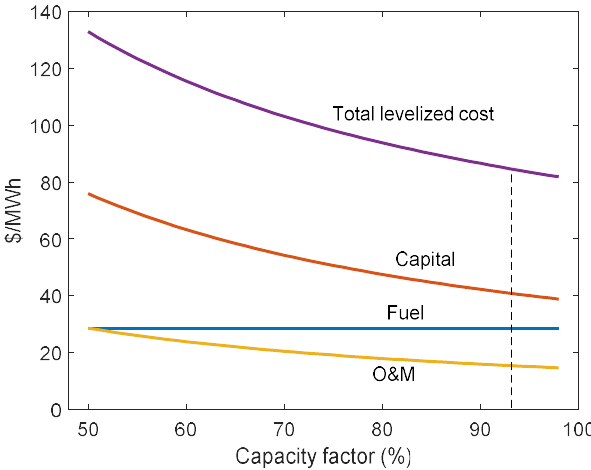
Figure 15. NB levelized electricity costs vs. capacity factor.